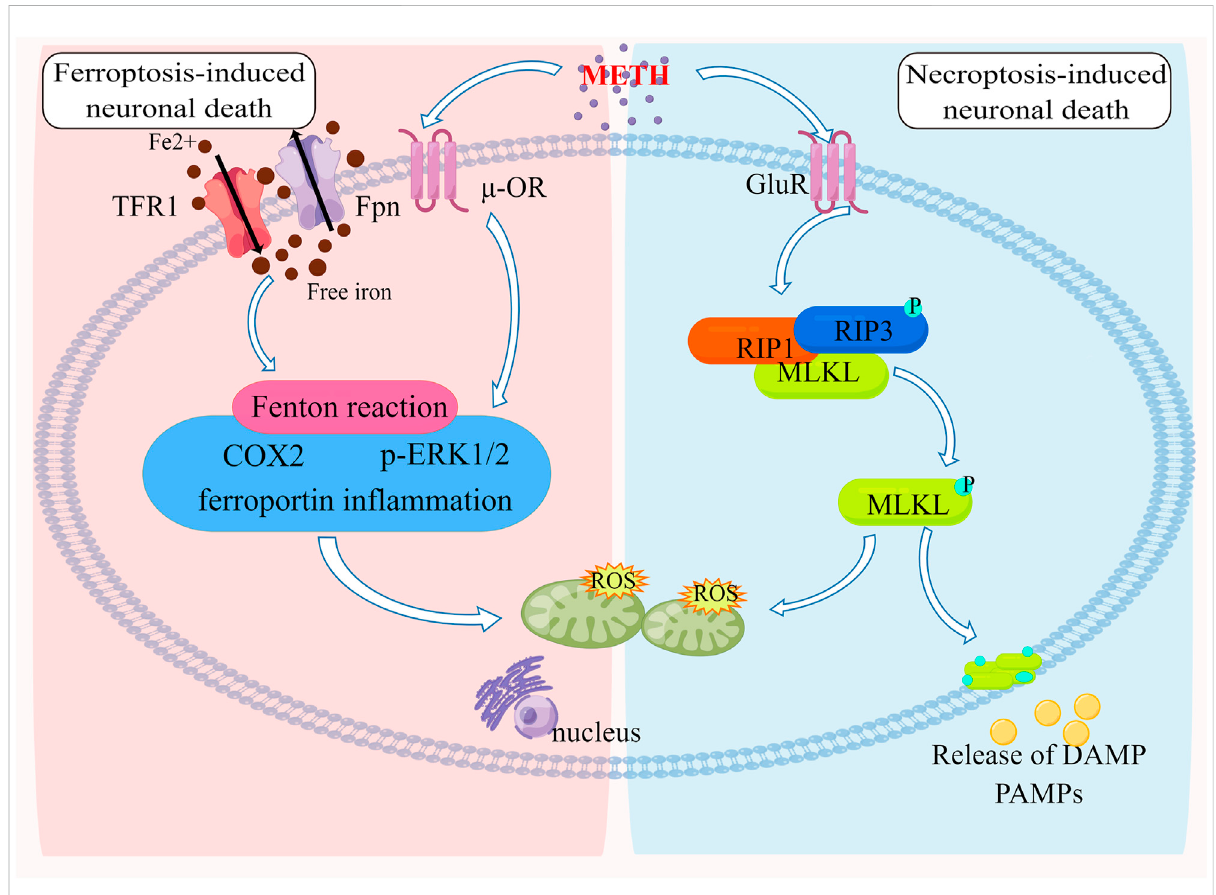
FIGURE 3 The Molecular pathways of ferroptosis and necroptosis induced by METH Neurotoxicity METH-induced neurotoxicity results from iron overloadbymodulatingtheexpressionofTfr1andFpn.Furthermore,mitochondrialoxidativedamagecausedbytheFentonreactionisaccompanied by ferroportin-induced in fl ammation as well as ERK1/2 and COX2 upregulation. A reduction or de fi ciency in GPx4 is associated with mitochondrial energy metabolism that exacerbates injury due to oxidative stress. METH can stimulate the formation of a complex between RIP3 and RIP1, resulting in RIP3 being phosphorylated. Once activated, RIP3 causes MLKL oligomers to form, which cause cell membrane disruption and mitochondrial oxidative damage, resulting in neuronal